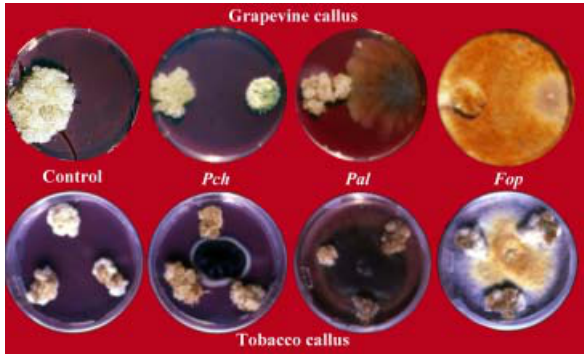
Fig. 2. Callus culture of grapevine cv. Italia or tobacco cv. White Burley grown in the presence of Phaeomoniel- la chlamydospora ( Pch ), Phaeoacremonium aleophilum ( Pal ) and Fomitiporia punctata ( Fop ).